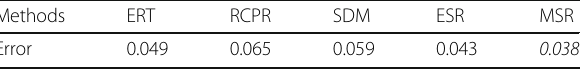
Table 4 Comparisons of different face alignment methods on FRGC database